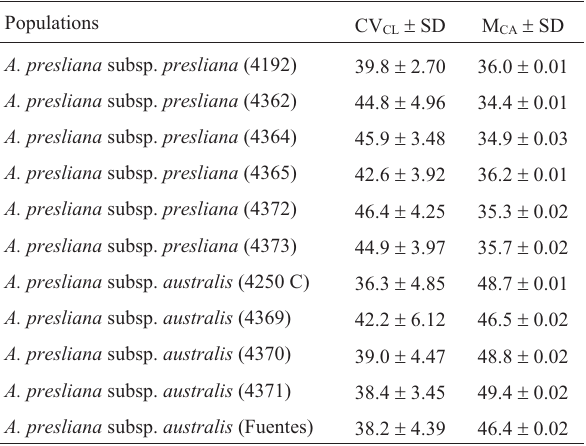
Table 1 - Karyotype features of the subspecies of Alstroemeria presliana. CV CL = Coefficient of variation of chromosome length; M CA = Mean centromeric asymmetry index according to Peruzzi and Eroglu (2013); SD = Standard